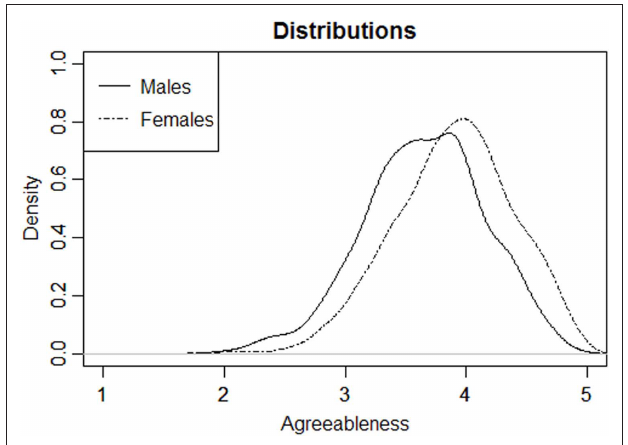
FIguRE 10 | Overlapping distributions of Agreeableness for men and women. Vertical axis indicates density, or the proportion of the sample in a given area under